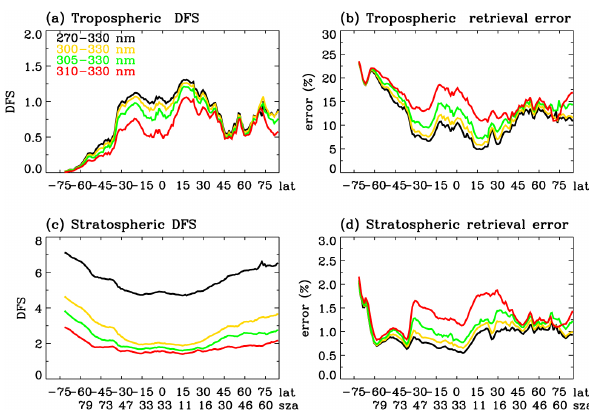
Fig. 1. Retrieval characteristics with the four spectral ranges be- tween 270nm and 330nm, calculated from OMI level 1b data in orbit 9522 on 30 April 2006. In the left panels (a, c) , the means of degrees of freedom for signal (DFS) in the troposphere and strato- sphere are plotted in 1 ◦ latitude bins (80 ◦ S to 80 ◦ N) with solar zenith angles given. The right panels (b, d) show the correspond- ing retrieval errors in tropospheric and stratospheric ozone columns, normalized to the a